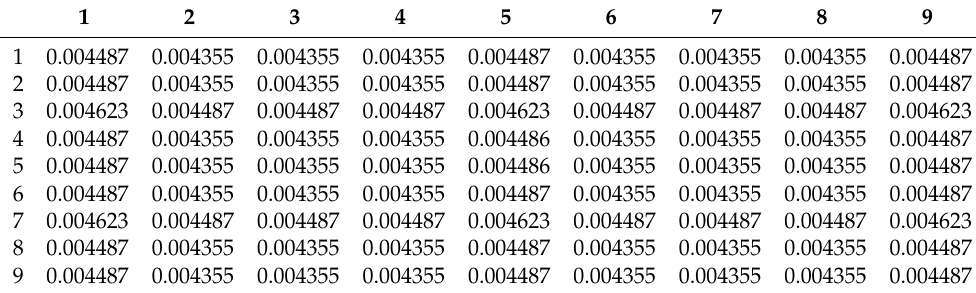
Table 3. Power value (Watts) of each aperture with crosstalk suppression stop array (Y axis, δ = − 2°). 1 2 3 4 5 6 7 8 1 2 3